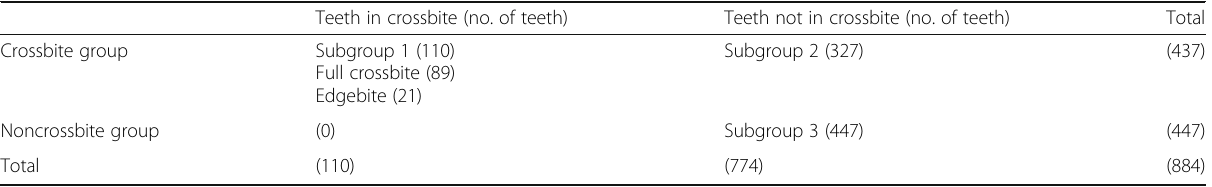
Table 3 Distribution of the subgroups (SGs) Teeth in crossbite (no. of teeth) Teeth not in crossbite (no. of teeth) Total Crossbite